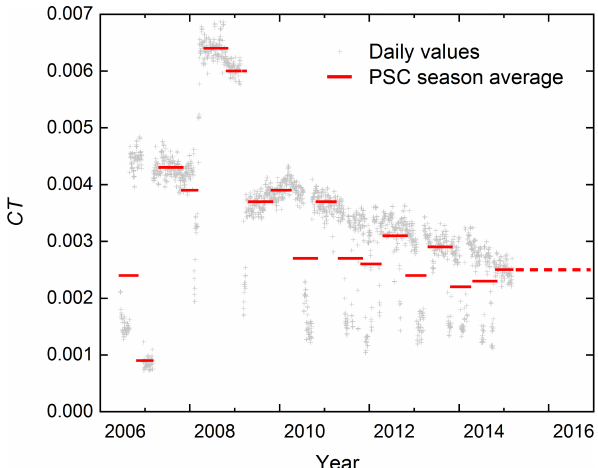
Figure A1. Time series of CT calculated from daily values of δ mol , meas over the course of the CALIPSO mission, as well as the averages over PSC